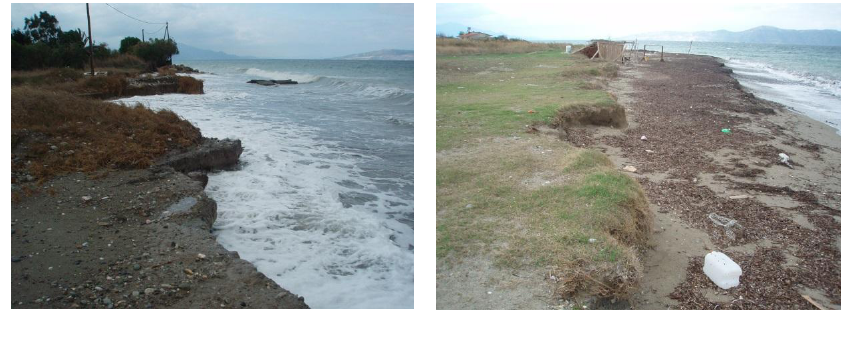
Figure 5. Field photographs from locations where the coastal erosion rates are of the order of 1 m/yr, during 2011 RTK-GPS survey. The hazard of destroying the life lines is high (see electricity pole at the left) even though several deposition and erosion periods are observed